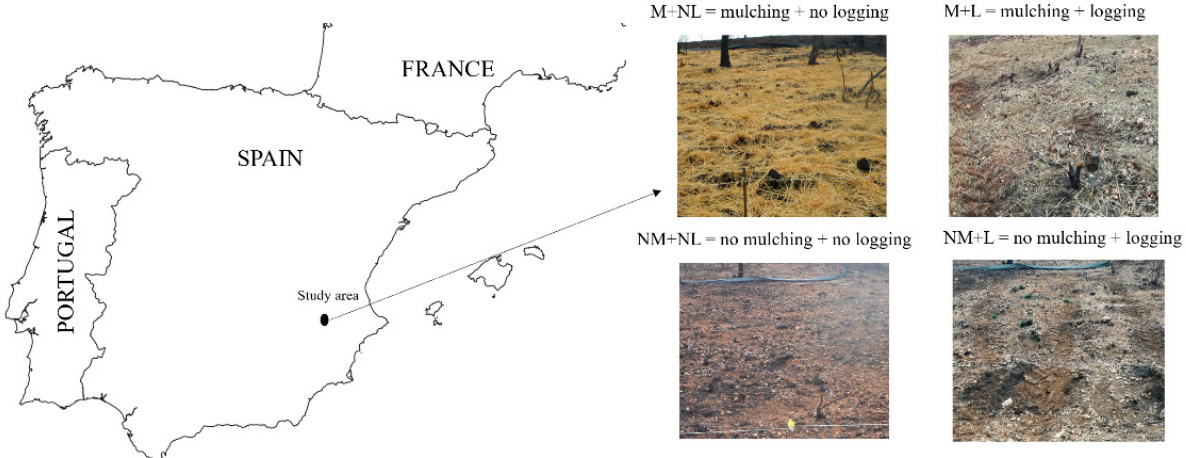
Figure 1. Geographical location of the study area (Sierra de las Quebradas forest, Castilla-La Mancha, central-eastern Spain). Mulching and logging operations.